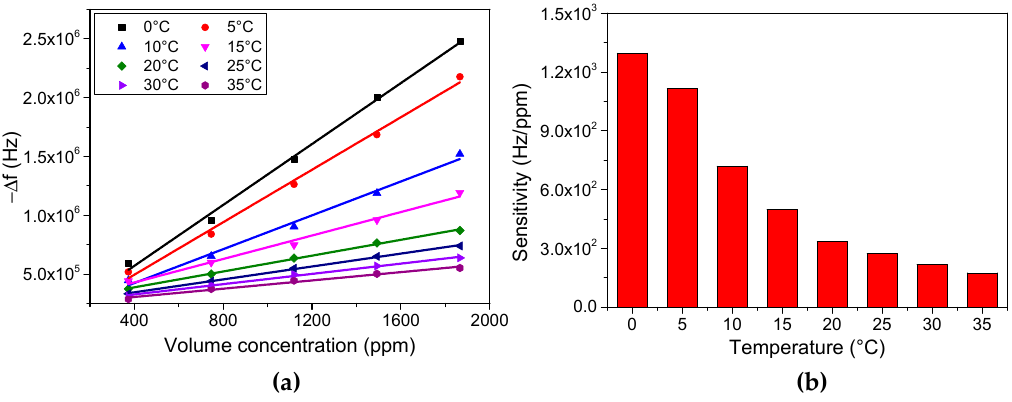
Figure 9. Temperature dependence of PET-coated FBAR for humidity sensing. ( a ) Frequency shift with respect to both the environmental temperature ranging from 0 °C to 35 °C and the volume concentration of water vapor changing from 373 ppm to 1866 ppm; ( b ) sensitivity of PET-coated FBAR with the environmental temperature changing from 0 °C to 35 °C.